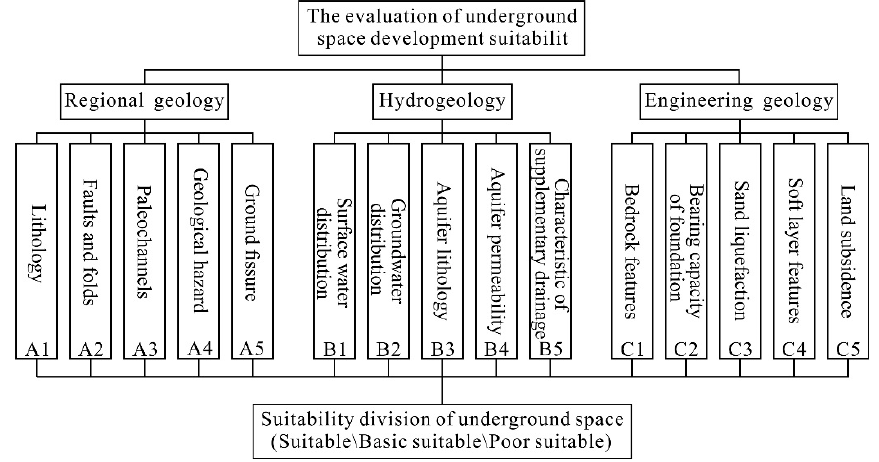
Figure 8. Hierarchical structure model. Table 3. Single ranking and consistency test of the criteria level judgment matrix.